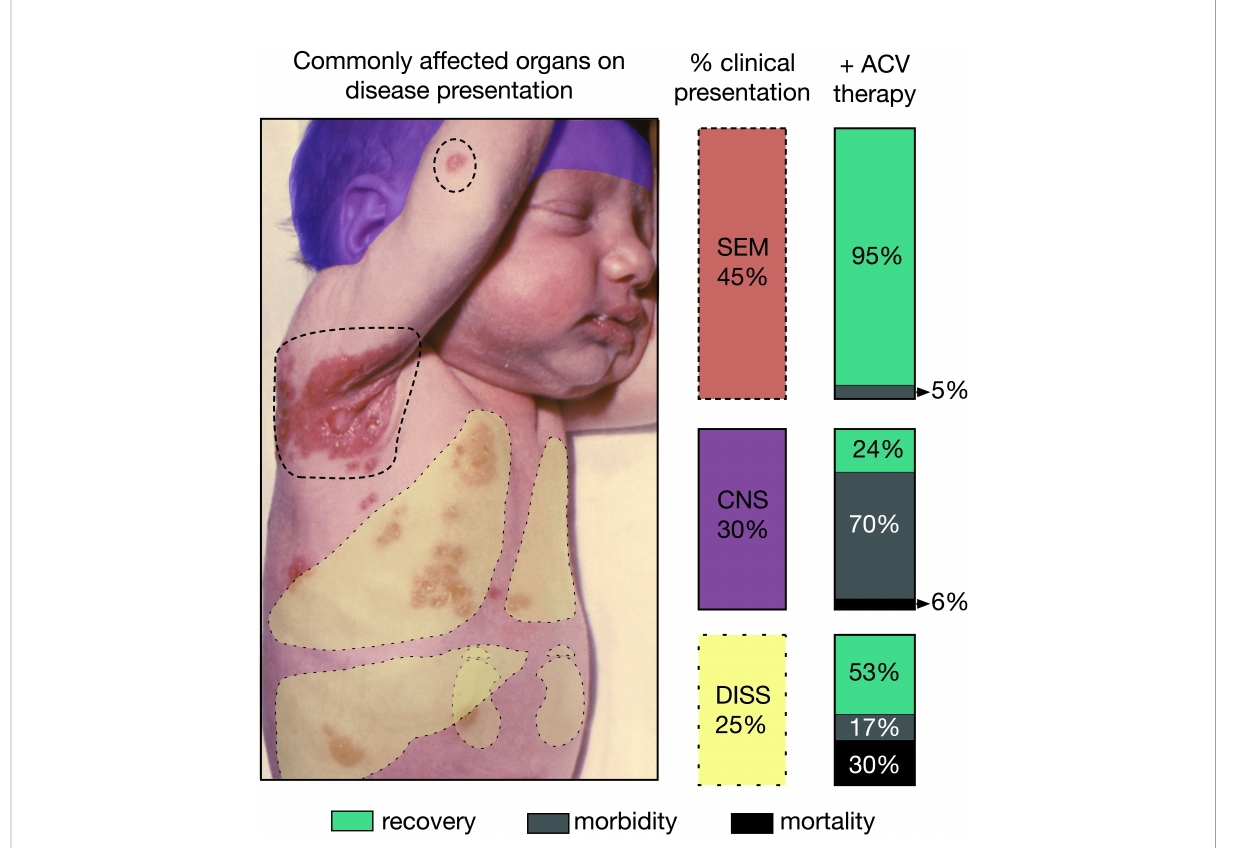
FIGURE 2 Consequences of neonatal herpes simplex virus (nHSV). Graphic depicting the different presentations and their respective estimated occurrence in the clinical setting. Outcomes of each disease presentation when treated with ACV are also displayed for each presentation to the right of color- coded columns. Skin, eye and mouth (SEM) disease often shows characteristic lesions, some of which are highlighted with dotted lines. Disseminated (DISS) can often affect lungs, liver, kidneys, and adrenals depicted as yellow overlays. Central nervous system (CNS) disease depicted as a purple overlay over affected infant ’ s head. Infant ’ s image courtesy of K.L. Herrmann, Centers of Disease Control public image